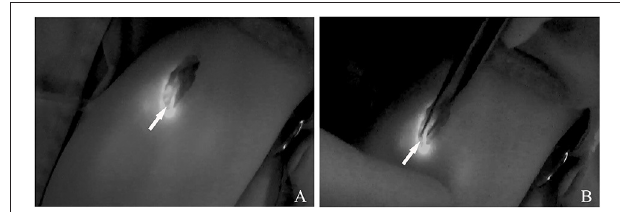
FIGURE 2 | (A) ICG lymphography indicates the localization of the afferent lymph vessels. (B) Inflow occlusion is conducted by bipolar electrocoagulation. Arrow head , lymph vessel.